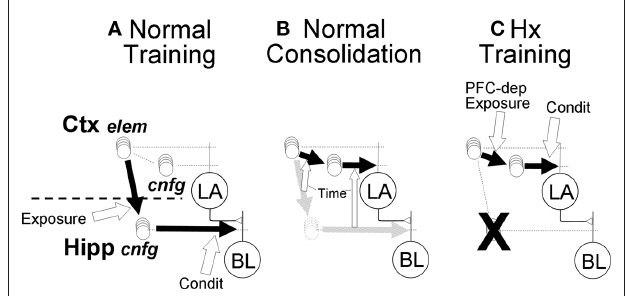
FigurE 6 | pathways for context (configural) fear conditioning in normal and hippocampal FrAT. (A) An effective pathway (bold black arrow) from sensory-representation cortex to hippocampus is rapidly established by hippocampal NMDA-dependent LTP during exposure to novel configural stimuli (white block arrow indicates conditions for establishment of pathway). Once a hippocampal representation forms, conditioning potentiates afferent synapses on BL principal cells. (B) Consolidation. Over time (weeks) after context exposure or training, hippocampal representations of context get replaced by cortical ones, and the strength of cortical context-representing neuron synapses on LA cells get adjusted so that the new cortical pathway will produce behavior similar to that produced by the hippocampal pathway that it replaces. Open block arrows indicate these gradually developing replacements (all aspects of consolidation are PFC-dependent in FRAT). (C) In absence of hippocampus (ablated, not suppressed) stimulus exposure causes rapid cortical synaptic change resulting in establishment of cortical representations neurons for configural stimuli (Ctx, cnfg); this process is PFC-dependent. Once cortical representations form, conditioning potentiates their synapses on LA principal